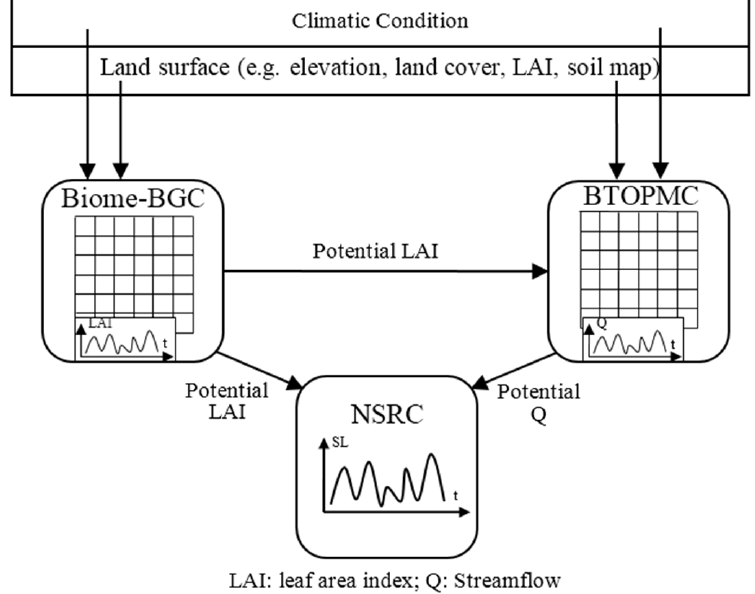
Figure 3. Model integration and data flow within models. Table 1. A summary of input datasets for parameterizing different models.